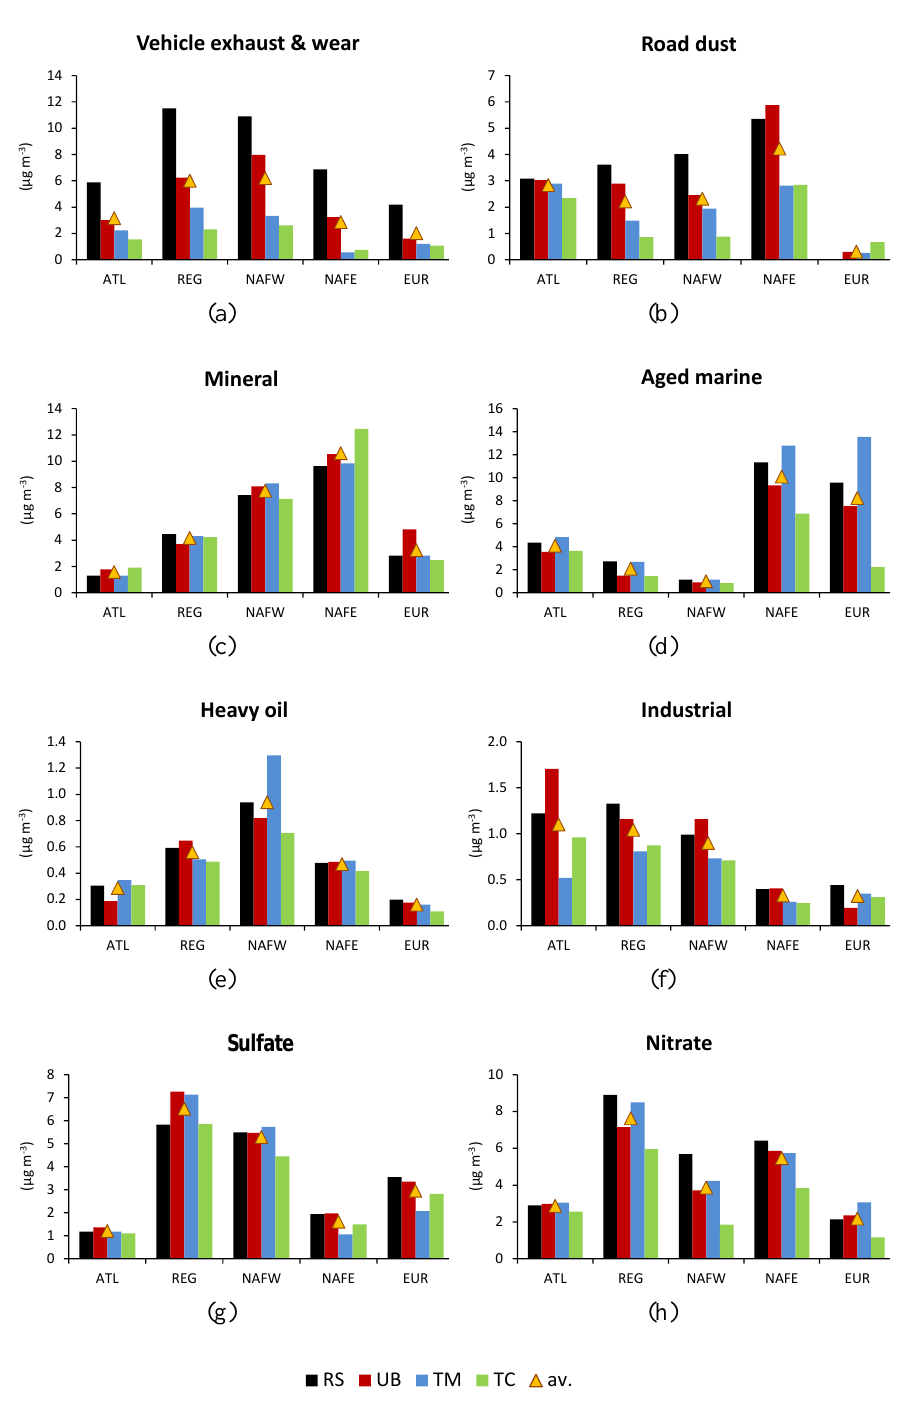
Figure 6. Average PM 10 contributions from the eight PMF factors at each of the sites (RS, UB, TM and TC) under different atmospheric scenarios (Atlantic, ATL; Regional, REG; North African west, NAFW; North African east, NAFE and European, EUR) during the SAPUSS